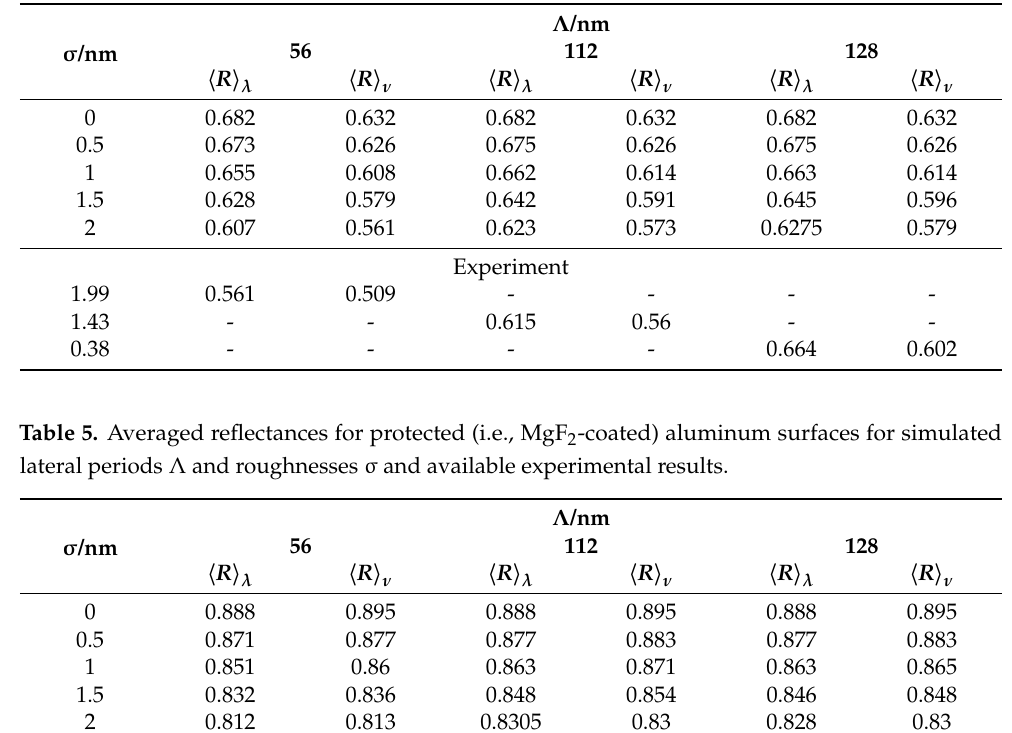
Table 4. Averaged reflectances for unprotected (i.e., alumina-coated) aluminum surfaces for simulated lateral periods Λ and roughnesses σ and available experimental results.